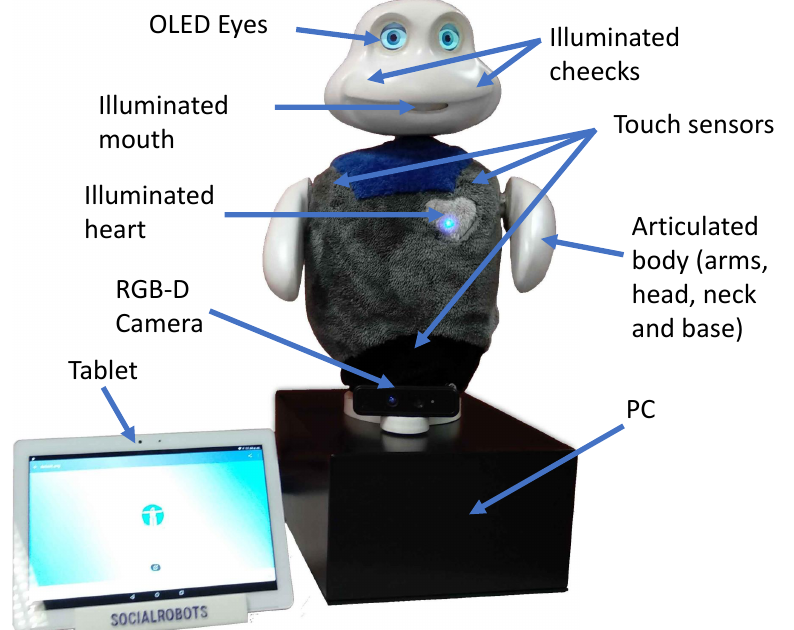
Figure 1. The social robot Mini.